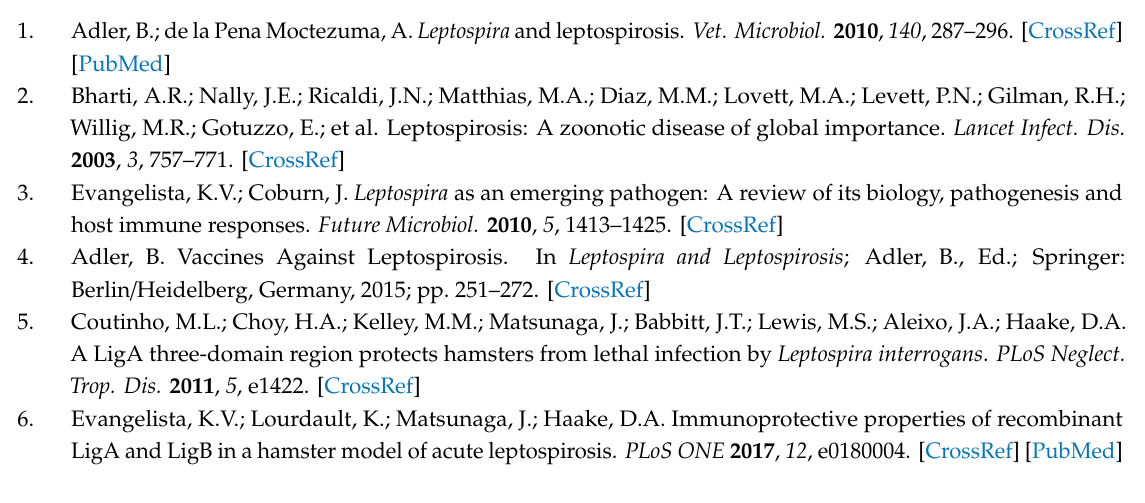
Figure S1: Total anti-LigAc IgG antibody titers in the vaccinated hamsters; Figure S2: Antibody levels in the vaccinated hamsters; Figure S3: The reactivity of hamster sera to rLigAc, rLipL32, and BSA; Figure S4: The reactivity of hamster sera against rLigAc and rLipL32; Figure S5: Histopathology of lung, liver, and kidney in the surviving hamsters vaccinated with various vaccine formulations (Table 1); and Figure S6: Statistical analysis of correlation between total LigAc-specific IgG titers, pathology score, and leptospiral burden of surviving hamsters in IM and SC LigAc